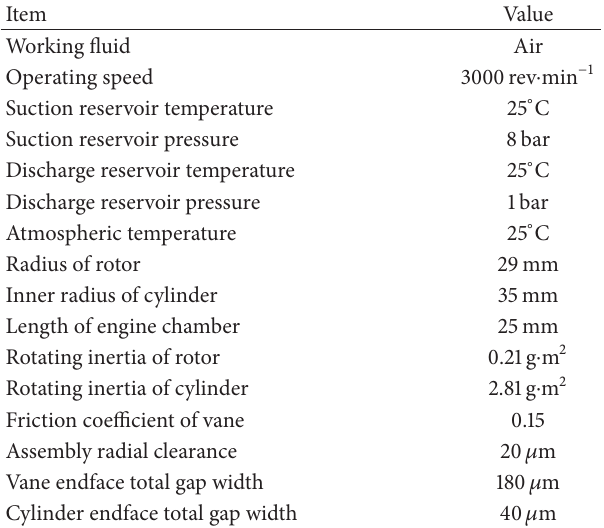
Table 1: Benchmark operating conditions and major